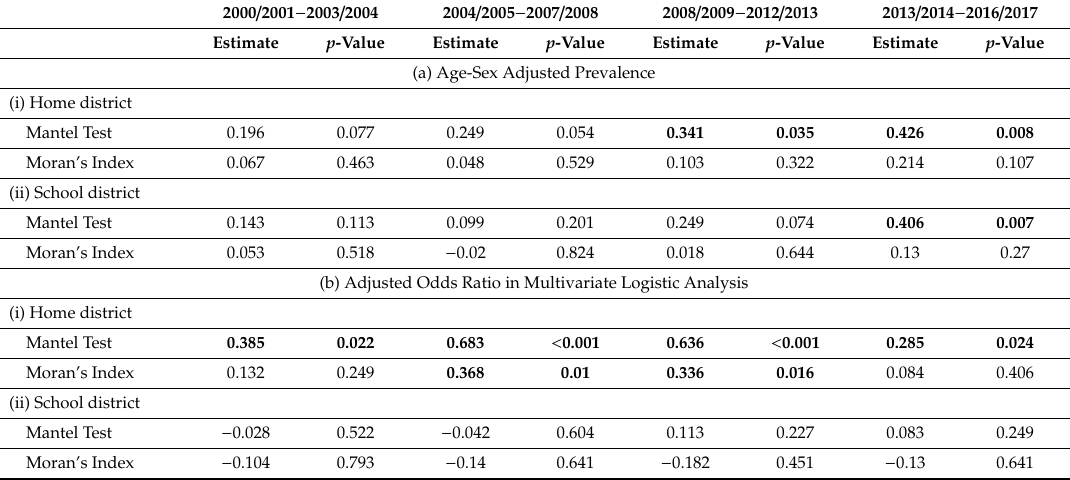
Table 5. Correlation coe ffi cients of Mantel test and Moran’s Index by home district and school district. 2000 / 2001 − 2003 / 2004 2004 / 2005 − 2007 / 2008 2008 / 2009 − 2012 / 2013 2013 / 2014 − 2016 / 2017 Estimate p -Value Estimate p -Value Estimate p -Value Estimate p